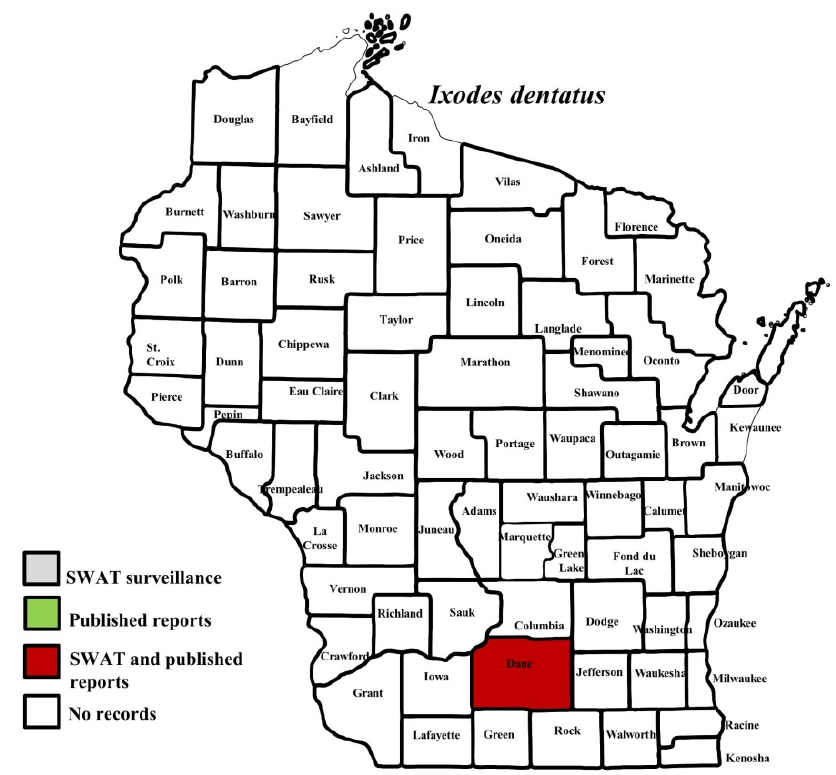
Figure 10. County records for Ixodes dentatus in Wisconsin [28].